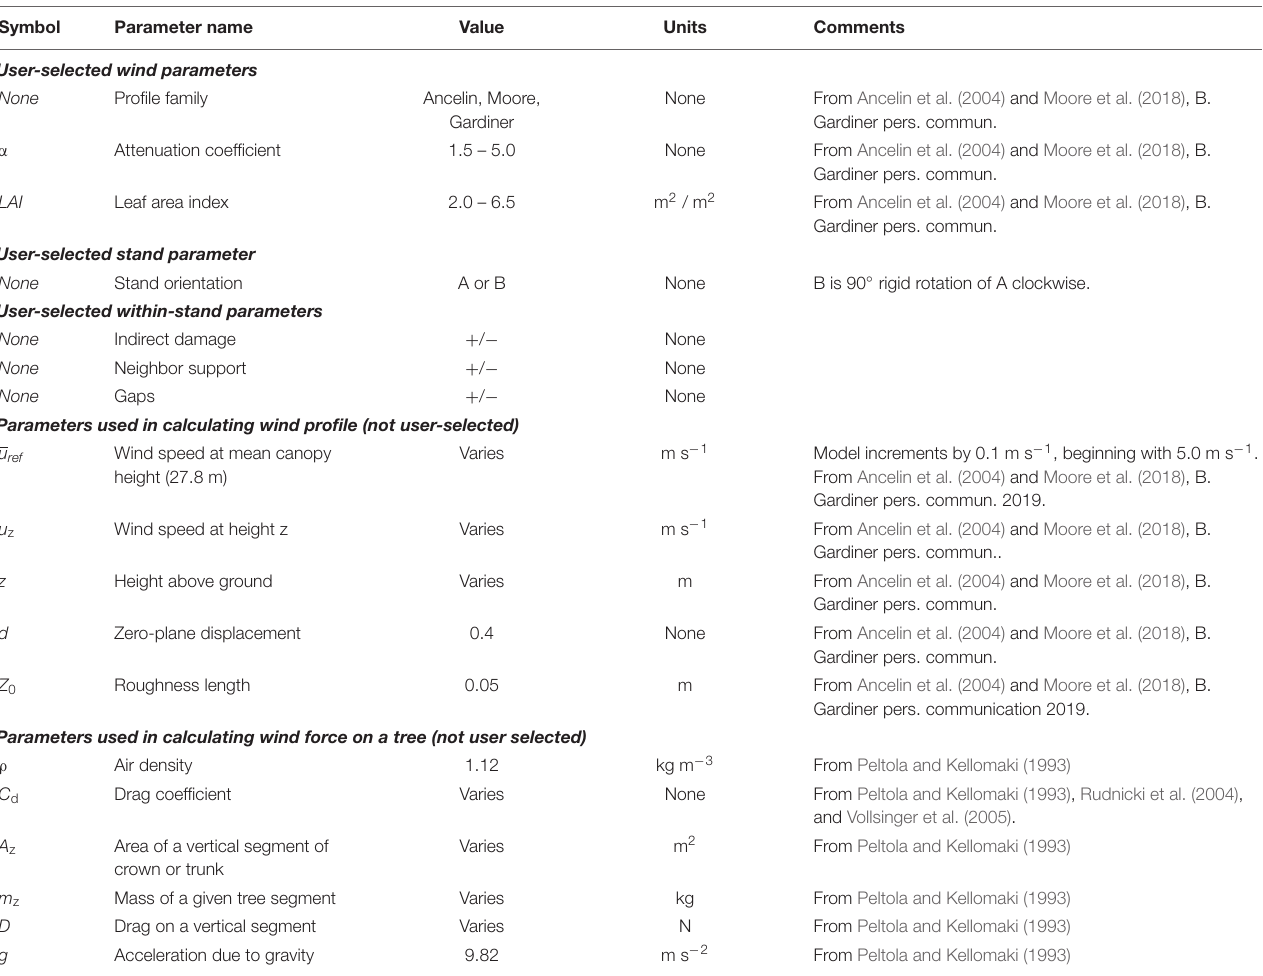
TABLE 1 | Parameters, values and units used in calculation of wind profiles and estimates of